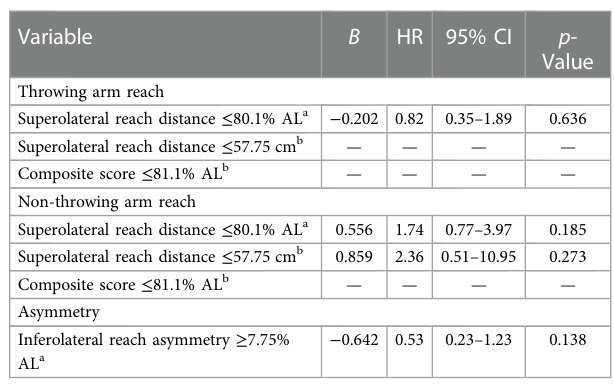
TABLE 3 Results of the Cox proportional hazard survival regression for sport-related injuries of the upper body (i.e., arm, shoulder, torso, and head) by throwing arm.